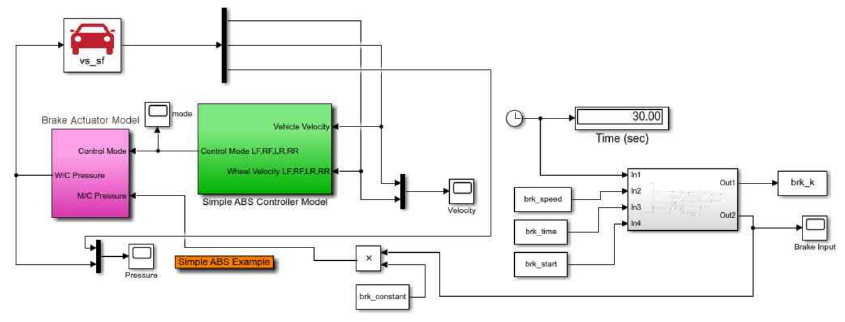
Figure 17. MATLAB/Simulink simulation model: target speed, required acceleration, and decelera- tion as per the applied regenerative force were obtained from this simulation.